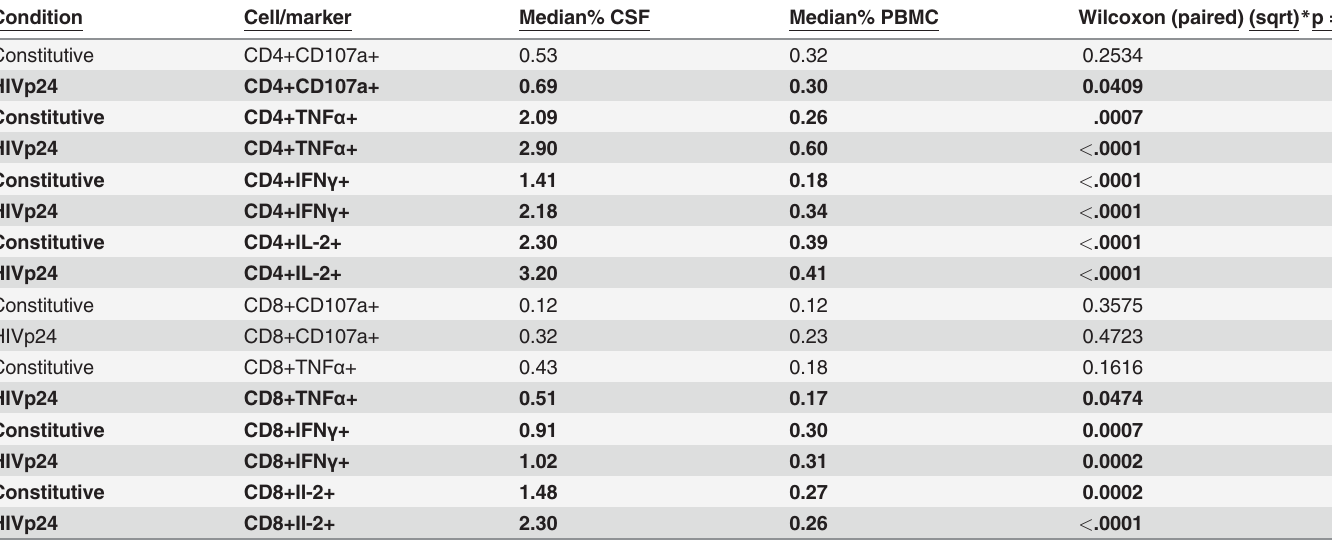
cytokine responses were compared at 3 different HIV RNA levels: undetectable, 40 – 400, and > 400. Selection of these categorical levels was based on the lower limit of quantitation (LLQ) for our HIV RNA assay (40 copies/ml) and the median HIV RNA level (381 copies/ml, or approxi- mately 400) among subjects who had HIV RNA levels above the LLQ. Since preliminary analy- ses indicated that patterns were consistent for the 3 cytokines, CD8 T-cell TNF α , IFN γ , and IL- 2 responses were combined (and not differentiated) in Fig. 2. Data groups were compared using a Wilcoxon Rank Sum test. Based on antigen dose response curves, we predicted a shallow bell shaped curve with peak responses at HIV RNA 40 – 400 copies/ml and lower responses when an- tigen (HIV) was undetectable or > 400 c/ml. Such a pattern was observed for the non-impaired subjects (Fig. 2, triangles). However, the relationship differed for NC impaired subjects (circles): T-cell cytokine responses increased with HIV RNA level ( < 40 to > 400c/ml, p = 0.0004). As a result, CD8 T-cell cytokine responses of participants with NCI were significantly higher com- pared to those of unimpaired participants at higher levels of CSF HIV RNA ( > 400 c/ml, p < 0.0001). These findings suggest that NCI is more likely in individuals whose CD8+ T-cells re- spond to increasing HIV levels with correspondingly higher TNF α , IFN γ and IL-2 expression. This observation was specific to CD8+ T-cell cytokine responses: CD4+ T-cell cytokine re- sponses of impaired and unimpaired subjects both increased as a function of CSF HIV RNA. Lymphocyte subsets, cytokine expression and soluble activation markers in blood and CSF cells from NCI and unimpaired participants To identify characteristics of T-cell responses associated with NCI, all participant visits were separated on the basis of GDS score ( (cid:1) 0.5, < 0.5) at date of visit and compared in Table 3. Neu- rocognitive impairment was significantly associated with lower CD4+ T-cell levels, higher lev- els of CD8+ T-cells, a low CD4+/CD8+ ratio, and higher/detectable HIV RNA levels in CSF. With respect to T-cell function, constitutive CD8+ TNF α , IFN γ , and IL-2 expression levels were each significantly higher at impaired visits, compared to non-impaired visits. In contrast,